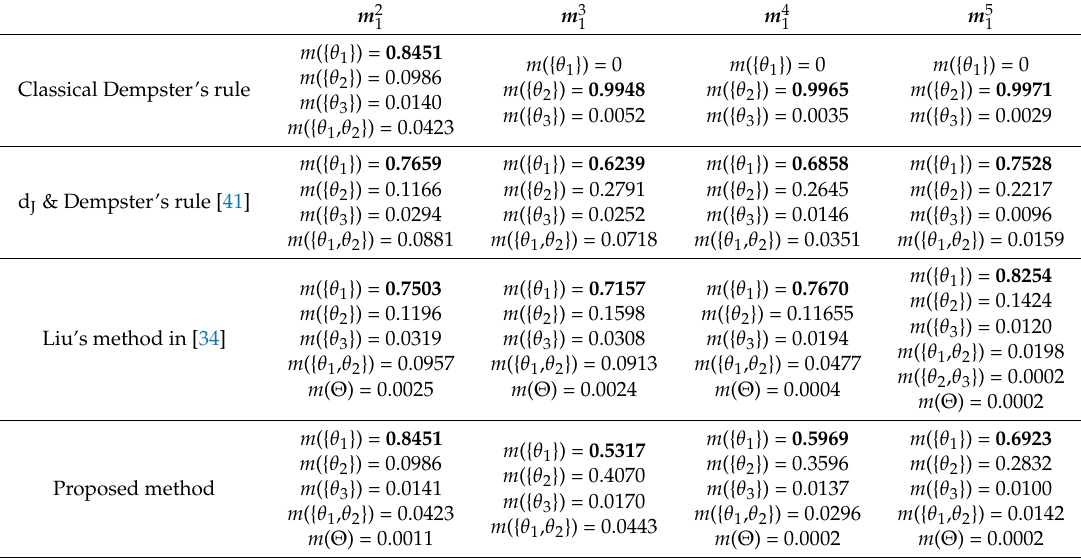
Table 2. Combination results of different evidence